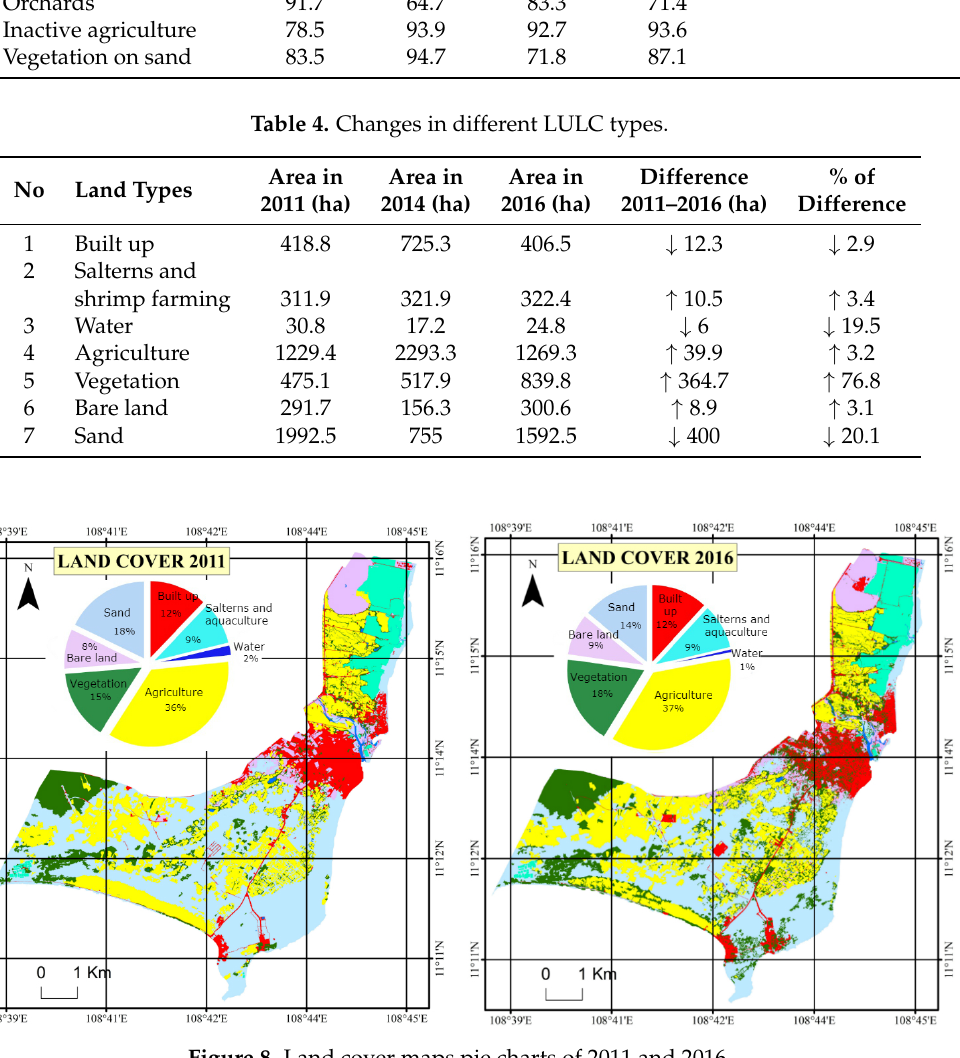
Figure 8. Land cover maps pie charts of 2011 and